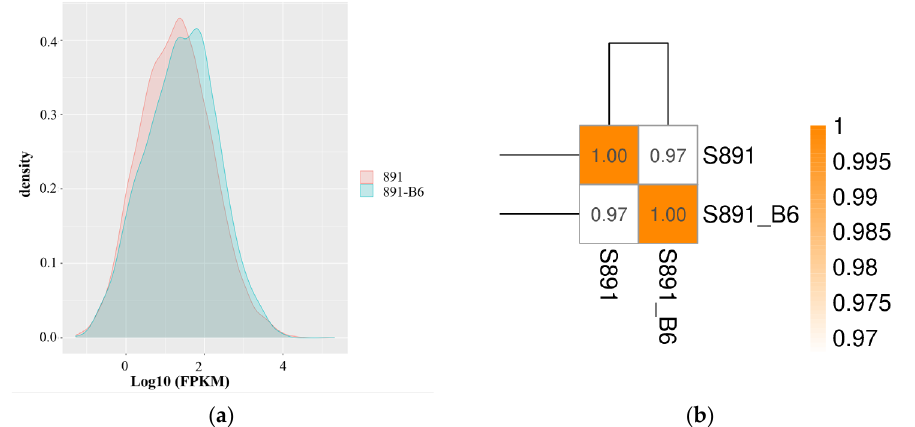
Figure 3. Analysis of the reads from RNA-Seq for strains 891 and 891-B6: ( a ) the map of FPKM density distribution; ( b ) the test results of sample correlation.